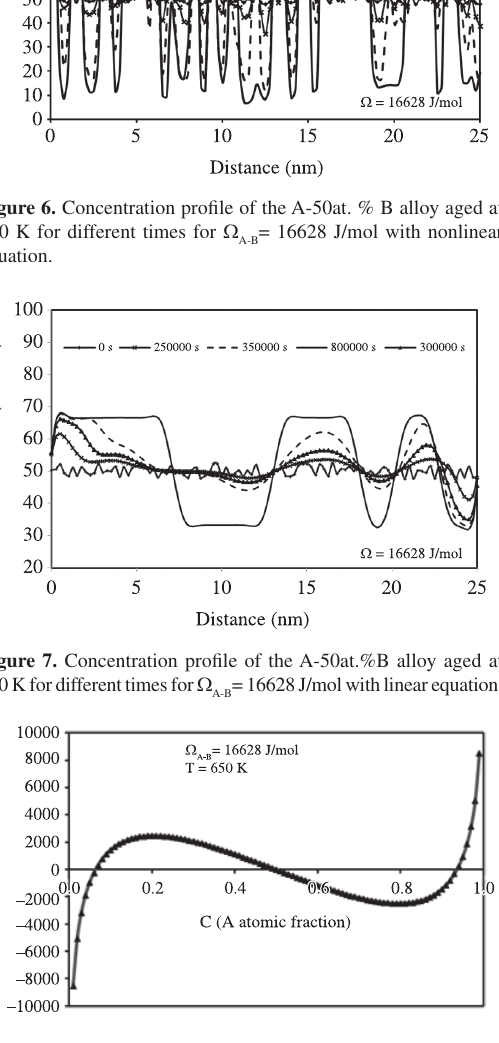
Figure 8. Plot of first derivative of free energy f vs. composition c = 16628 for Ω A-B